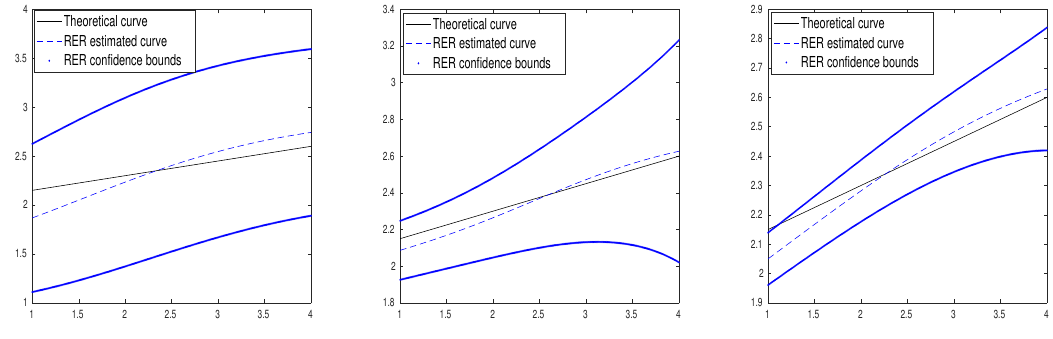
Figure 8: ρ 1 = 0.3 with CR ≈ 85% and n = 50, 200 and 400 respectively.